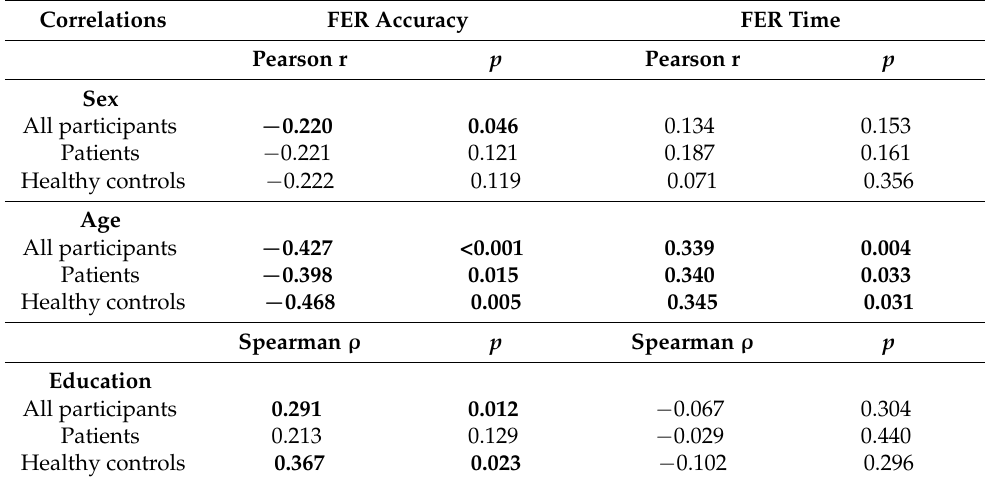
Table 3. Correlations between facial emotion recognition (FER)-accuracy/time, and sex, age, and education.